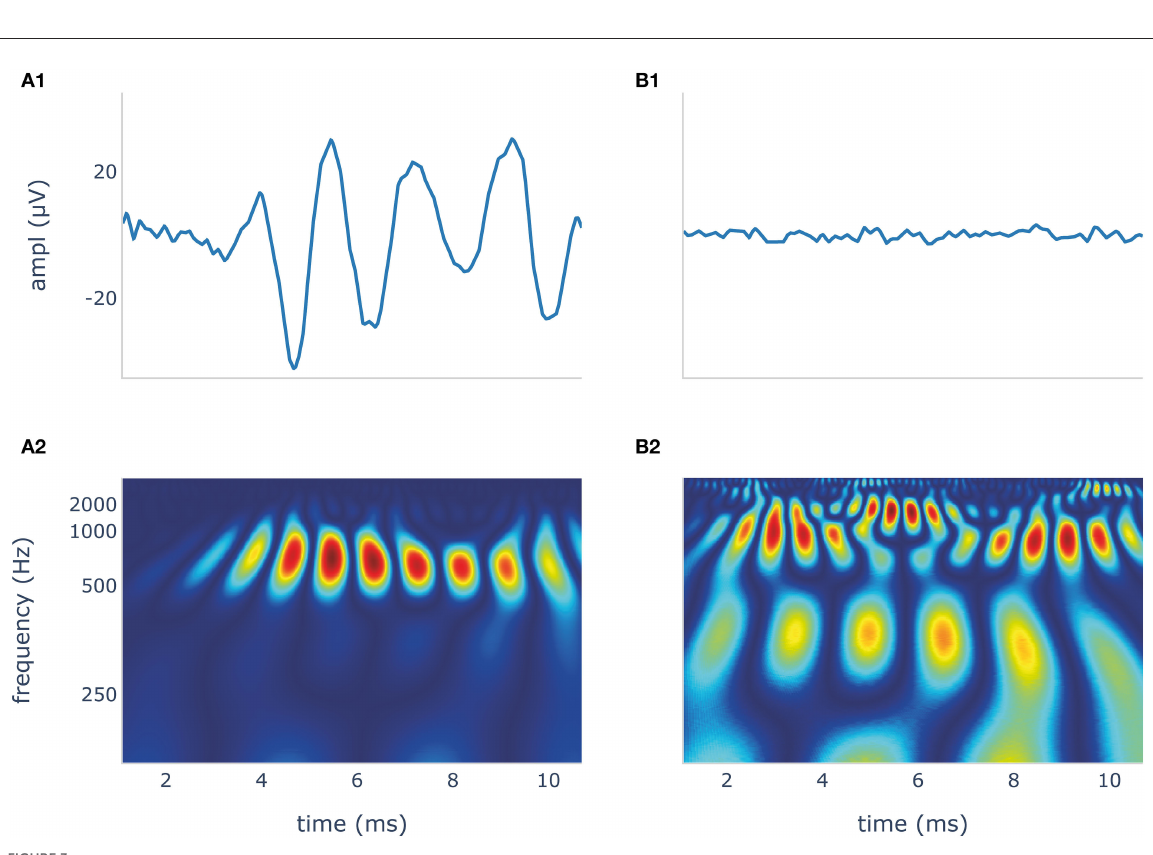
amplitudes ( p < 0.001), and bigger SNR ( p < 0.001) than sub-threshold stimulation. However, this was not the case for 250 Hz stimulation amplitudes ( p = 0.104). Regarding visual analysis, near-threshold levels showed significantly